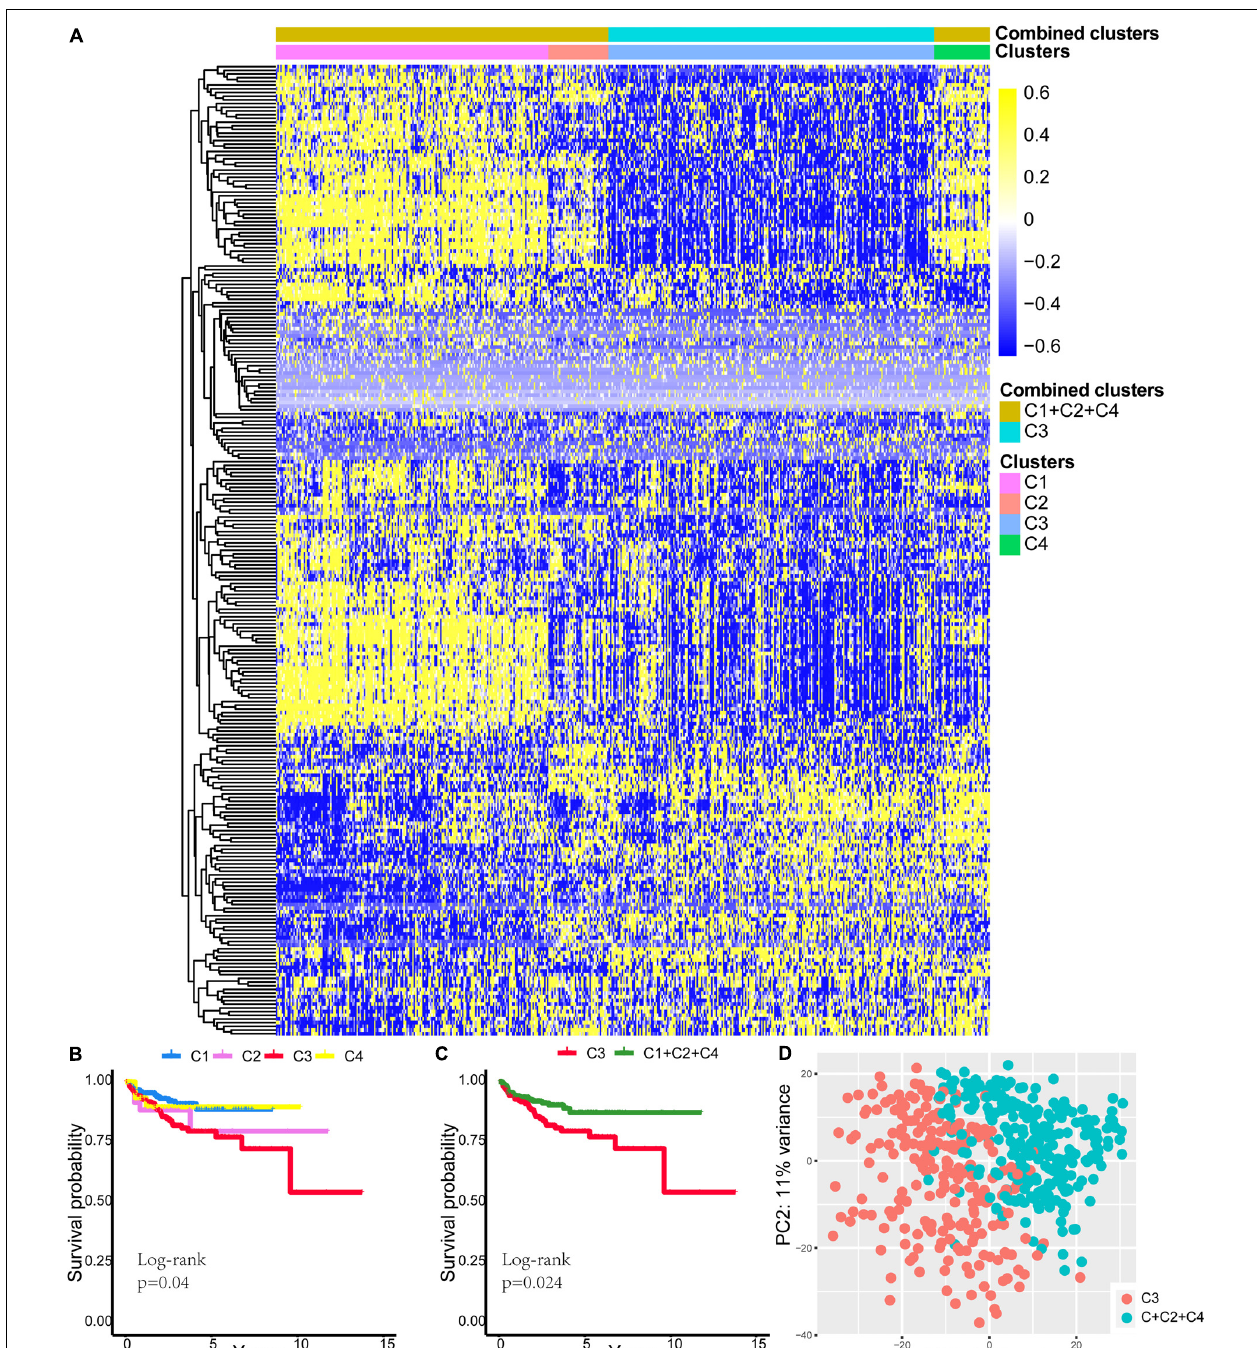
FIGURE 2 | Differences in characteristics of patients in different clusters. (A) The heatmap for 263 immune DEG expressions of 487 patients. (B) Survival curves for C1, C2, C3, and C4 groups. (C) Survival curves for C3 and C1 + 2 + 4 groups. (D) Principal component analysis showed that patients in the C3 group were significantly different from patients in the C1 + 2 + 4 group. DEGs, differentially expressed